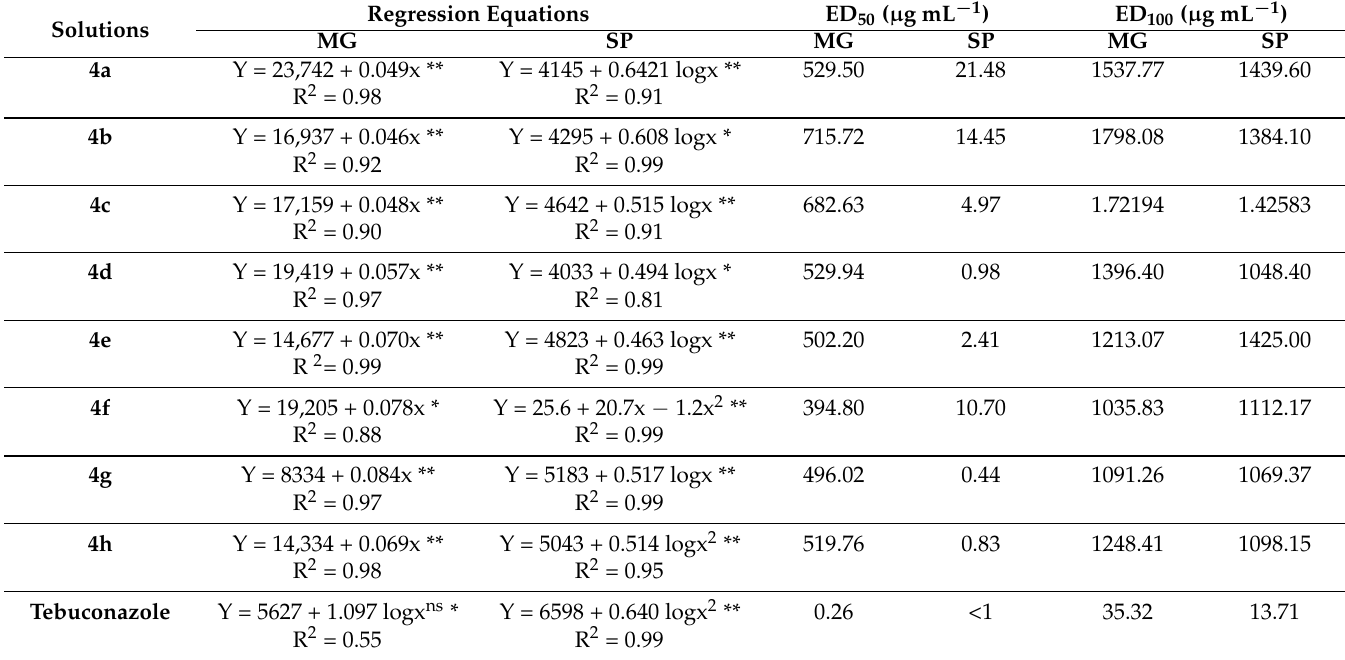
Table 3. Regression equation models obtained from fungicide evaluation of triazoles ( 4a – 4h ) and tebuconazole against Colletotrichum gloeosporioides .